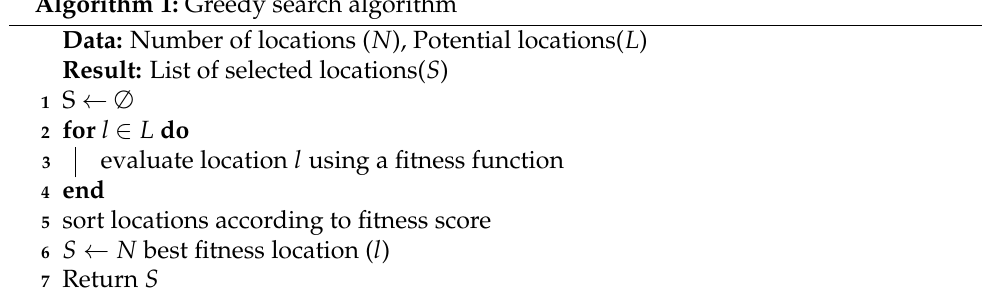
Algorithm 1: Greedy search